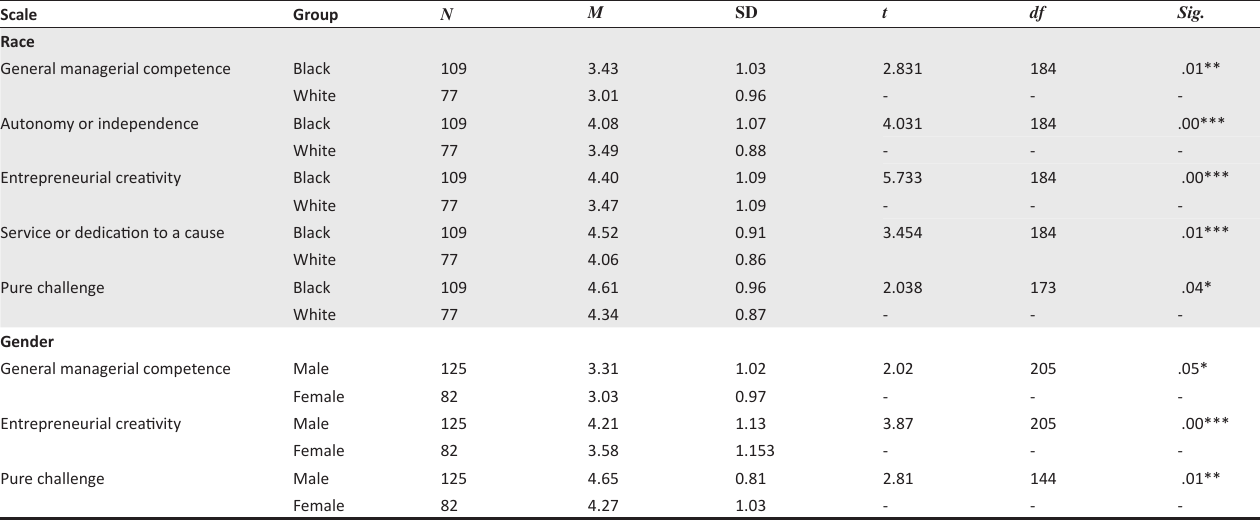
TABLE 5b: COI scale significant differences between race, gender, marital and employment status groups: Independent t -test results ( N =